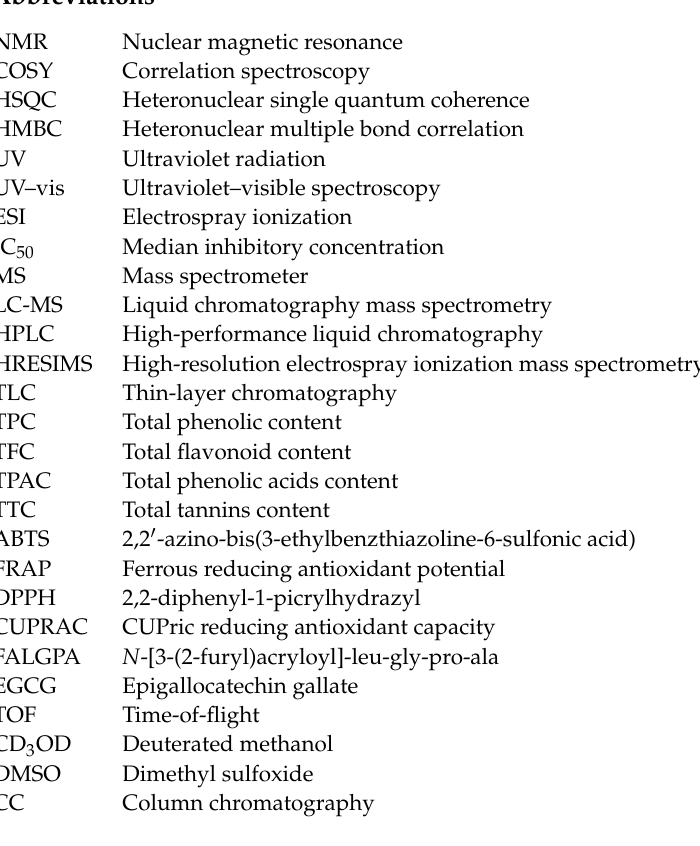
Figure S16: The qualitative assessment of SP1 . UV–vis chromatogram ( λ = 348 nm and λ = 270 nm) obtained by LC-PDA-MS; Figure S17: The qualitative assessment of SP2 . UV–vis chromatogram ( λ = 348 nm and λ = 270 nm) obtained by LC-PDA-MS; Figure S18: The qualitative assessment of SP3 . UV–vis chromatogram ( λ = 348 nm and λ = 270 nm) obtained by LC-PDA-MS; Figure S19: The qualitative assessment of SP4 . UV–vis chromatogram ( λ = 348 nm) obtained by LC-PDA-MS.; Figure S20: The qualitative assessment of SP5 . UV–vis chromatogram ( λ = 348 nm and λ = 270 nm) obtained by LC-PDA-MS; Figure S21: The qualitative assessment of SP6 . UV–vis chromatogram ( λ = 348 nm and λ = 270 nm) obtained by